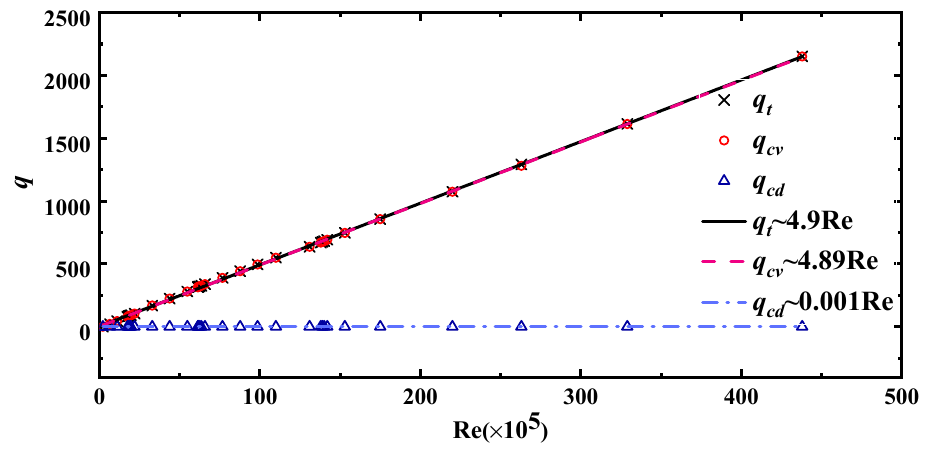
Figure 7. The values of various heat fluxes in curved cavity under different Re numbers and their fitting curves.